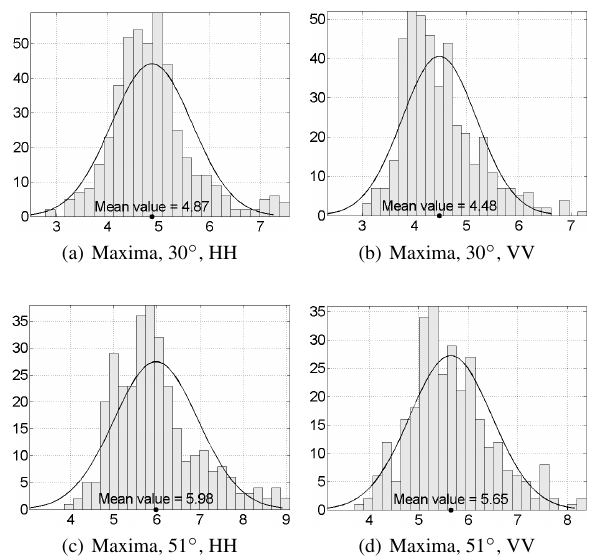
Figure 3. Hansaviertel, intensity distribution of maxima for dif- ferent polarizations and incidence